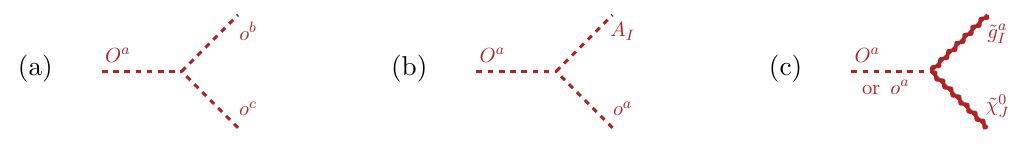
Figure 4. Diagrams for (a) scalar sgluon decay to pseudoscalar sgluons, (b) scalar decay to a light pseudoscalar Higgs boson and a pseudoscalar sgluon, and (c) heavy scalar or pseudoscalar decays to a gluino ˜ g I and a neutralino ˜ χ 0 . As usual, { I , J } ∈ { 1, 2 } . All diagrams vanish if R symmetry J is